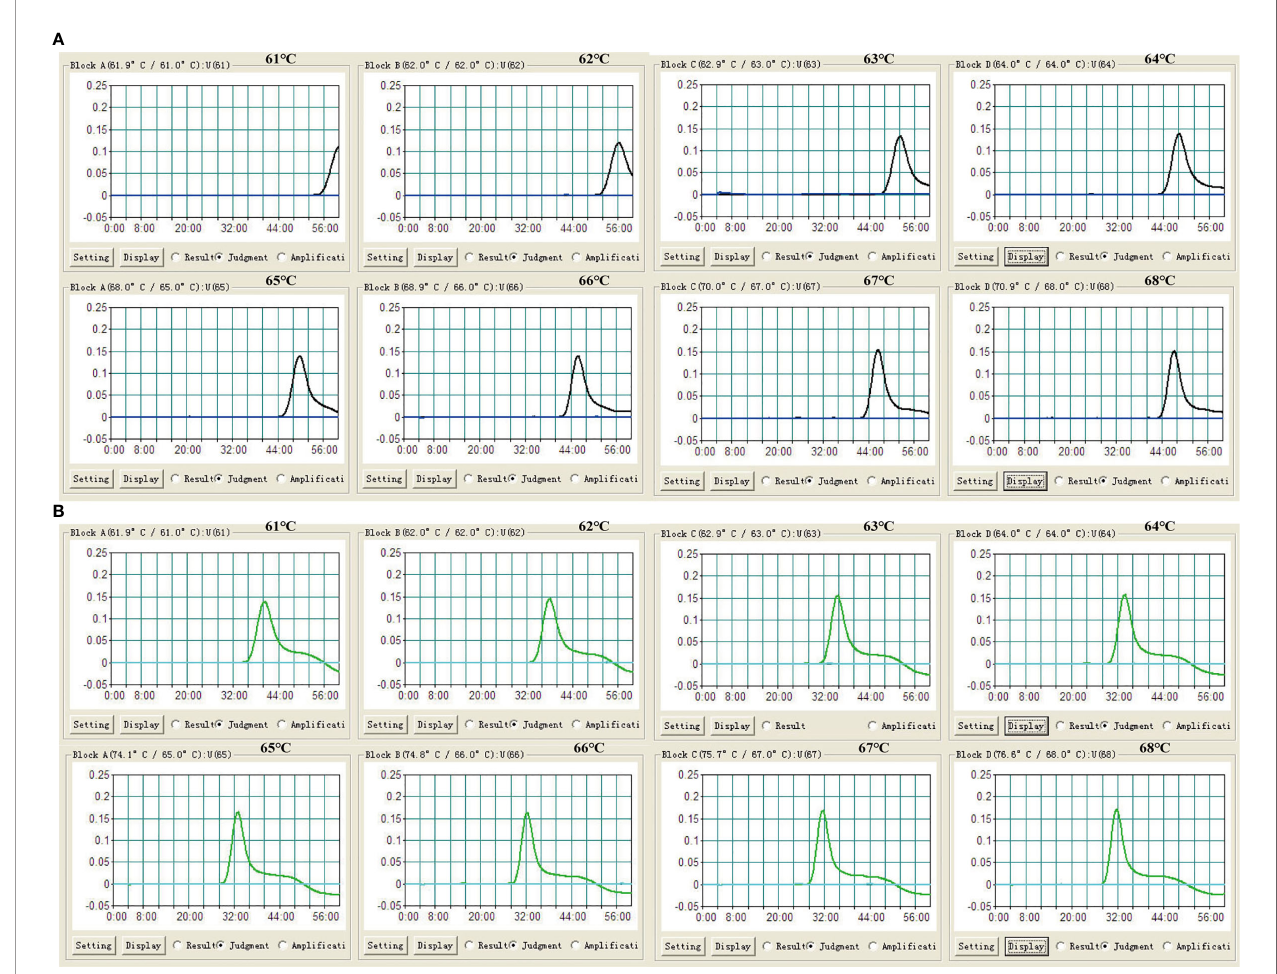
FIGURE 3 | Optimization of reaction temperature for LAMP assay. The LAMP reactions were monitored by real-time turbidimeter. (A) IS 6110 -LAMP. (B) IS 1081 - LAMP. Turbidity of >0.1 was deemed to be positive. Eight kinetic graphs (1-8) were acquired at different temperatures (61°C to 68°C, 1°C intervals) with 100 fg of H37Rv DNA template per reaction.